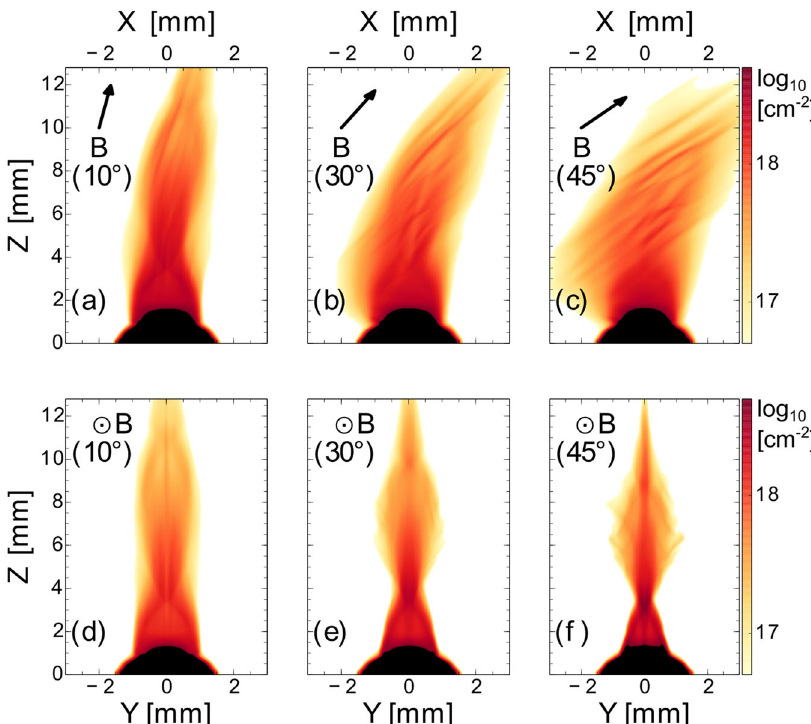
Fig. 5 Simulated plasma expansion vs. magnetic misalignment. 2D maps (in the xz and yz planes) of 3D MHD numerical simulations displaying the decimal logarithm of the integrated electron density along either x or y . Figures a , b , and c correspond to maps in the plane containing the magnetic fi eld whereas fi gures d , e , and f correspond to maps in the plane orthogonal to the magnetic fi eld. Thus, a , b , and c correspond to the laboratory measurements shown in Fig. 1B, and Figs. 2 and 3. All fi gures correspond to a time of 18 ns after the start of the plasma expansion. The black arrows indicate the initial magnetic fi eld direction. The target material is made of Carbon — see “ Methods ” section to get insights about the simulations and the reason for the difference with the experimental target